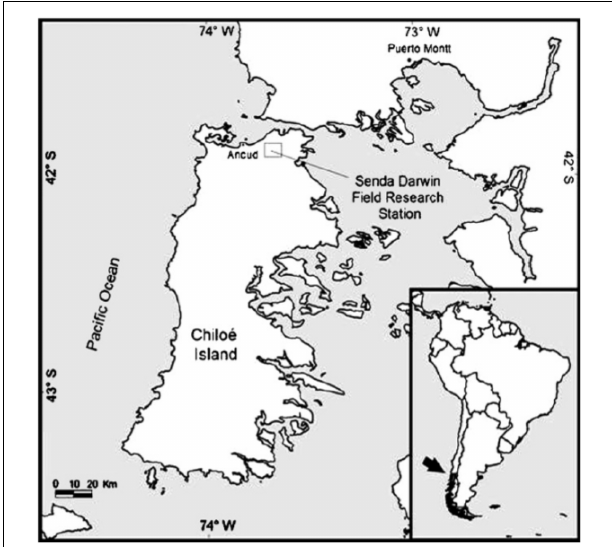
FIGURE 1 | Study site in Senda Darwin Biological Research Station, Chiloé Island, Southern South America, Chile.